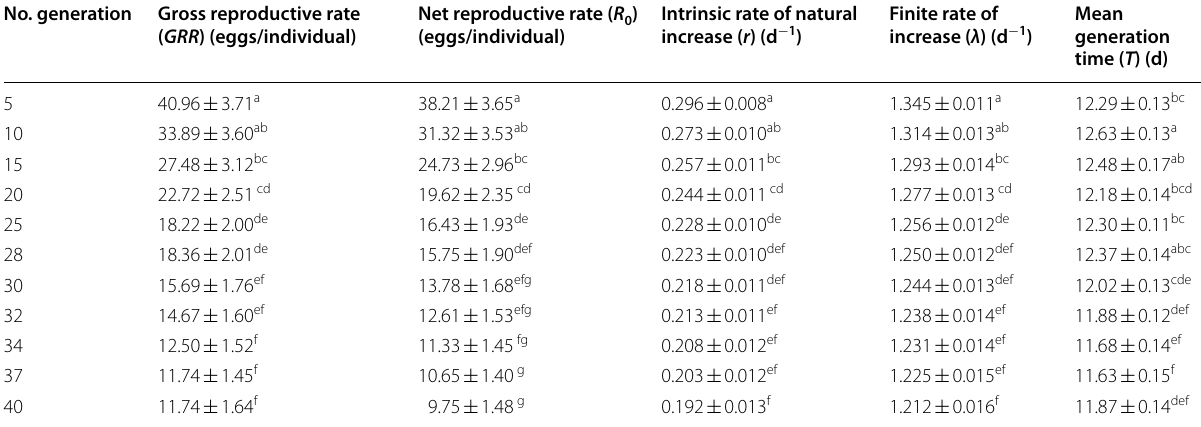
The means marked by the same letters within the same column are not significantly different (Paired-bootstrap test, P < 0.05)